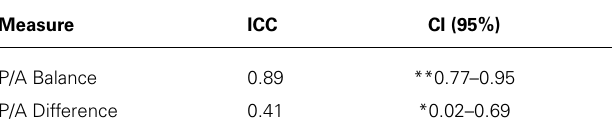
Table 2 | Intraclass correlation (ICC) coefficients and 95% confidence intervals (CIs) for patterning (P/A Balance) and raw count (P/A Difference)